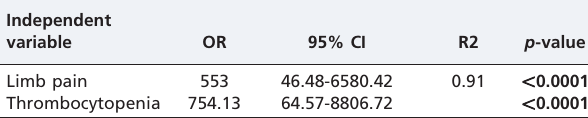
Table 4 - Logistic regression analysis to evaluate risk factors distinguishing acute lymphoblastic leukemia from systemic-onset juvenile idiopathic arthritis patients.